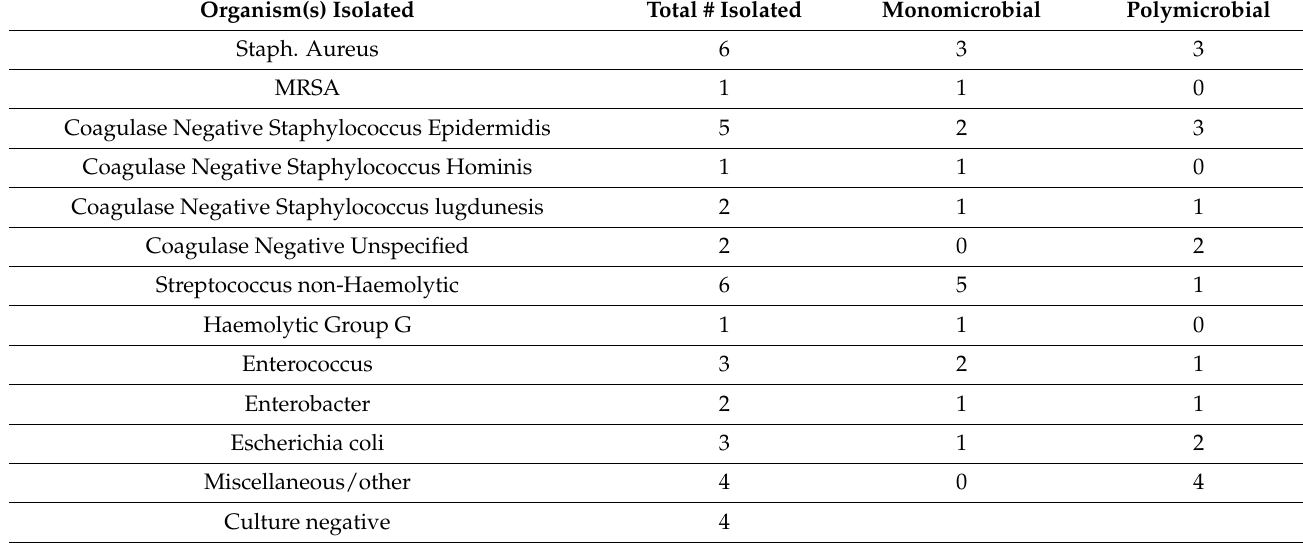
Table 3. Organisms cultured in entire patient